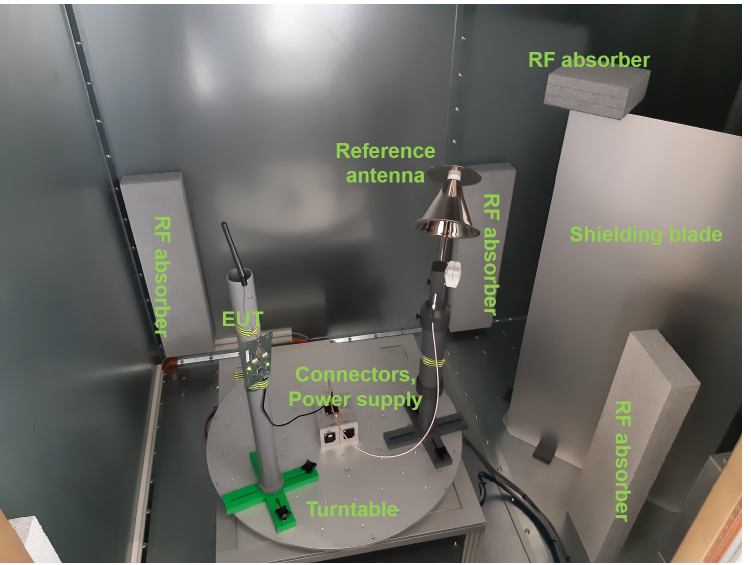
Figure 2. Photo of the measurement setup inside the